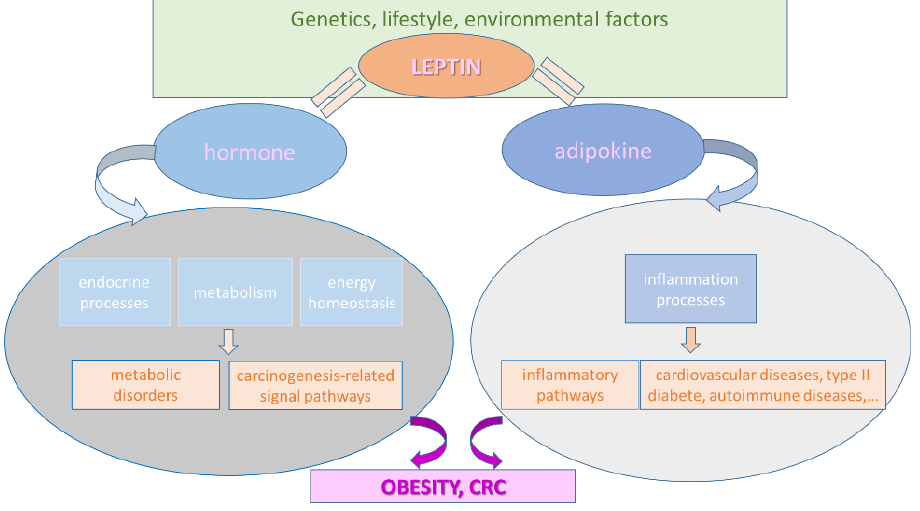
Figure 2. Leptin’s role in obesity and CRC.